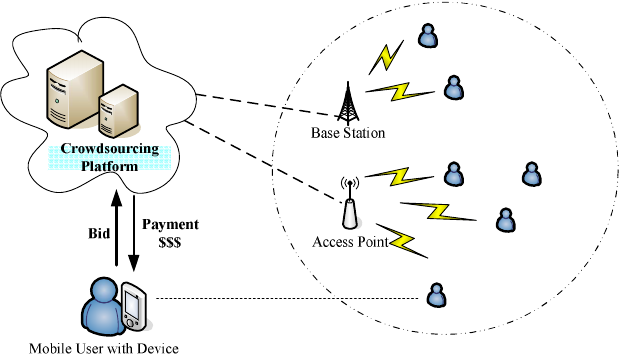
Figure 1. An overview of a Mobile Crowdsourcing System